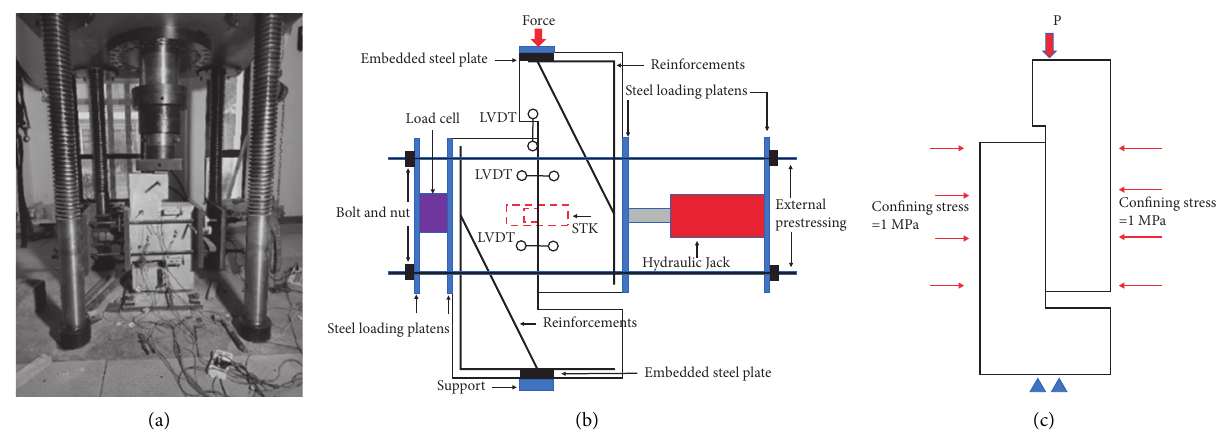
Figure 5: Test setup. (a) Test machine, (b) confining stress system, and (c) simplified